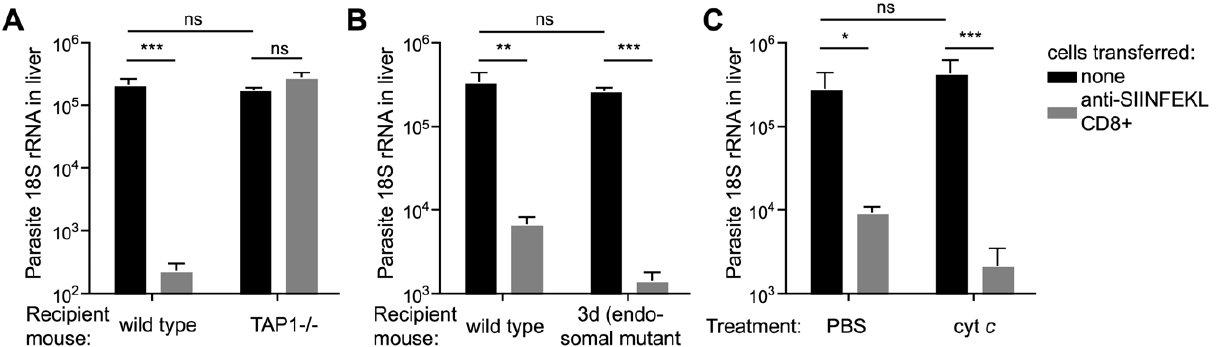
Figure 5. Antigen is directly presented to effector cells by hepatocytes. A. C57Bl/6 or TAP1-/- mice received 2 6 10 6 SIINFEKL-specific effector CD8 + T cells 3 hours prior to challenge with 5 6 10 3 P. berghei CS 5M sporozoites (grey bars); control mice did not receive effector cells (black bars). 40 hours later livers were taken and parasite rRNA concentration determined by real-time PCR (mean 6 SEM; n=4, data from one of 2 similar experiments). B. C57Bl/6 or 3d mice received 2 6 10 6 SIINFEKL specific effector CD8 + T cells 3 hours prior to challenge with 5 6 10 3 P. berghei CS 5M sporozoites (grey bars); control mice did not receive effector cells (black bars). 40 hours later livers were taken and parasite rRNA concentration determined by real-time PCR (mean 6 SEM; n=5, data from one of 2 similar experiments). C. Cyt c or PBS treated C57Bl/6 mice received 2 6 10 6 SIINFEKL specific effector CD8 + T cells 3 hours prior to challenge with 5 6 10 3 P. berghei CS 5M sporozoites (grey bars); control mice did not receive effector cells (black bars). Treated mice received 15 mg cyt c for 3 days starting the day before challenge. 40 hours after challenge livers were taken and parasite rRNA concentration determined by real-time PCR (mean 6 SEM; n=4).